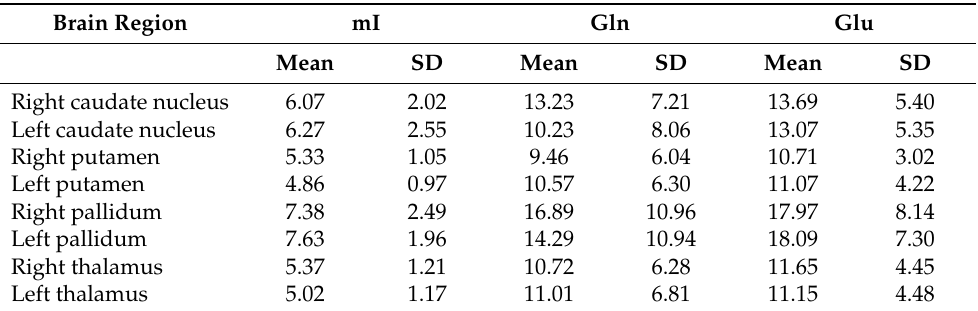
Table 2. Mean absolute Cram é r–Rao lower bounds of mI, Gln, and Glu and associated standard deviations (SD).